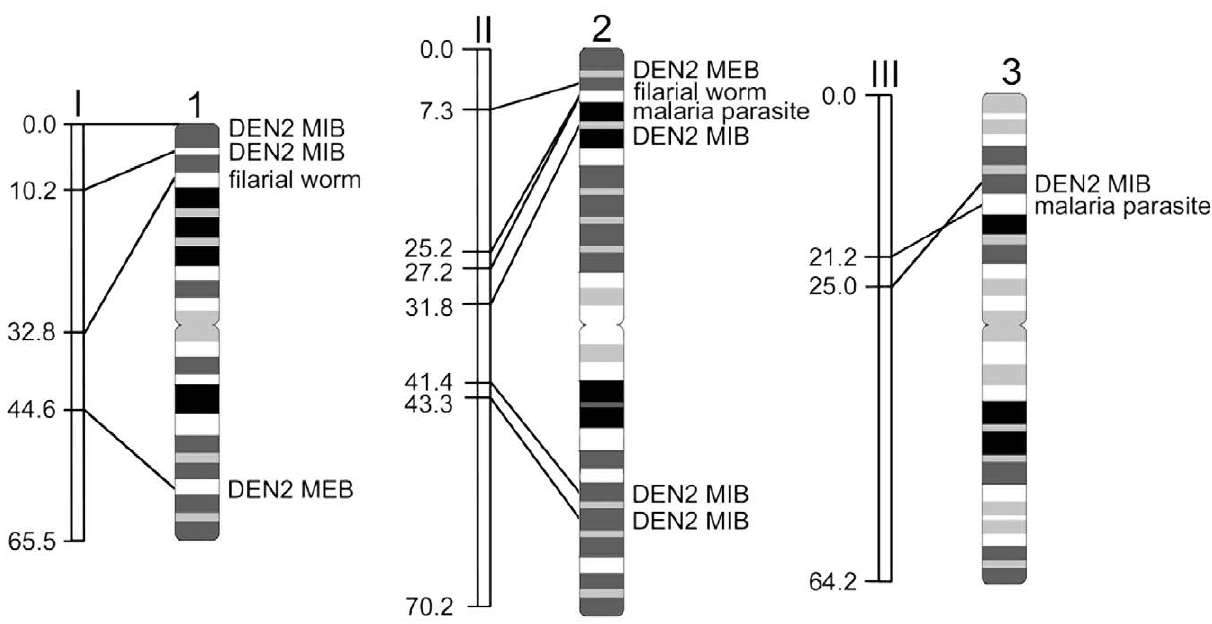
Figure 6. Localization of QTLs to various pathogens on linkage and chromosome maps of Aedesaegypti . The linkage positions of QTLs in cM on linkage groups I, II, and III are indicated on the left side. QTLs to dengue virus 2 (DEN2), midgut infection barrier (MIB), DEN2 midgut escape barrier (MEB), malaria parasite, and filarial worm are shown on the right sides of chromosomes 1, 2, and 3.